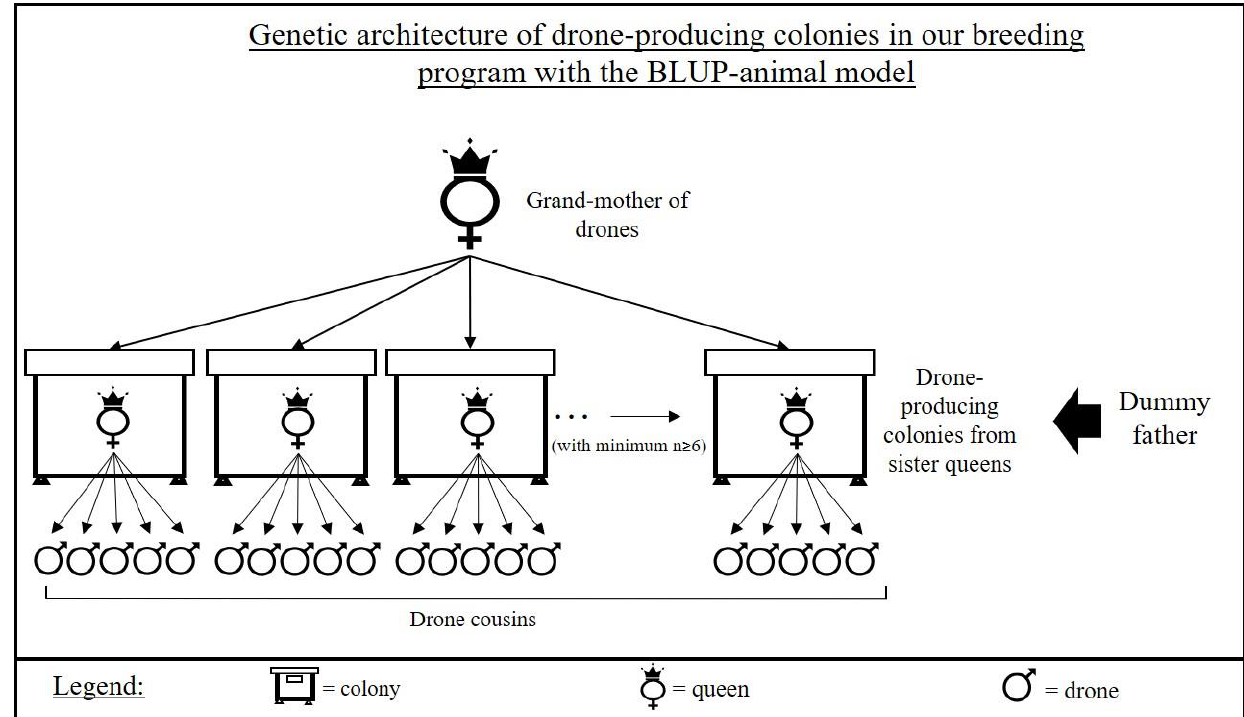
Figure 1. Model representing the dummy father used in our selection program with the BLUP-animal model. The dummy father is composed of a group of drone-producing colonies from sister queens. These queens from the same mother make it possible to obtain related drones (cousin drones) for reproduction.